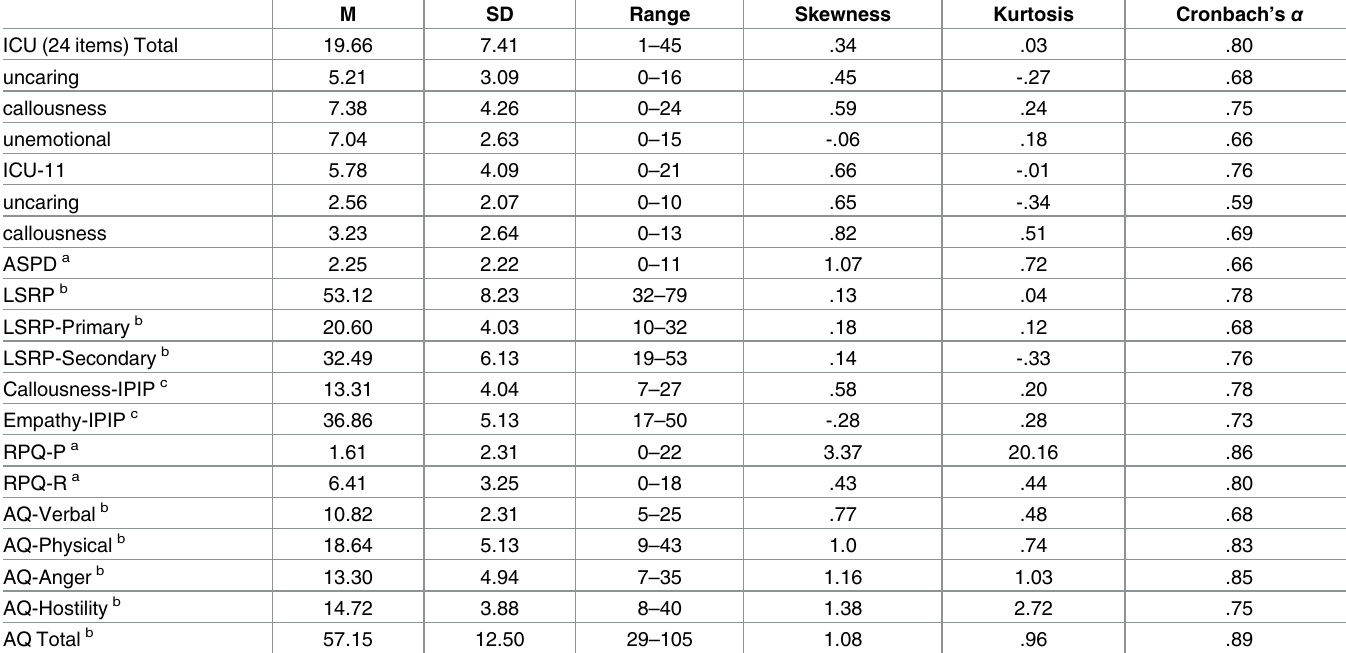
Table 4. Descriptivestatistics and correlations among ICU factors and external criteria in the current sample. M SD Range